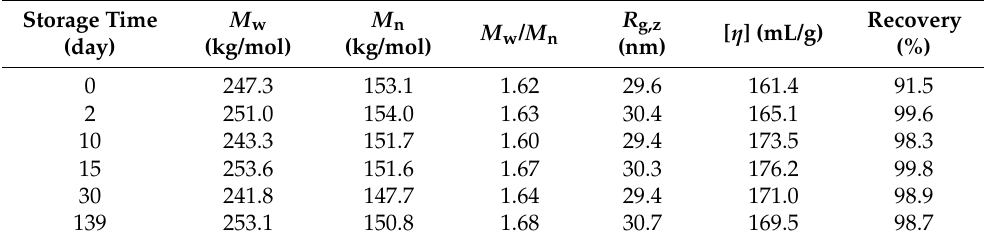
Figure 2. ( a ) RI and ( b ) LS at 90° signals as a function of elution volume, ( c ) molecular weight distribution curves, and ( d ) variation of M w and M n with storage time for PAA stored at − 18 °C. The label − 18 °C-0 d represents the original PAA solution, while − 18 °C-2 d represents that it was stored at − 18 °C for 2 days. Table 2. Molecular parameters of (6FDA-DMB) PAA in a concentrated solution stored at − 18 °C for different times, measured by GPC-RI-MALLS-VIS.